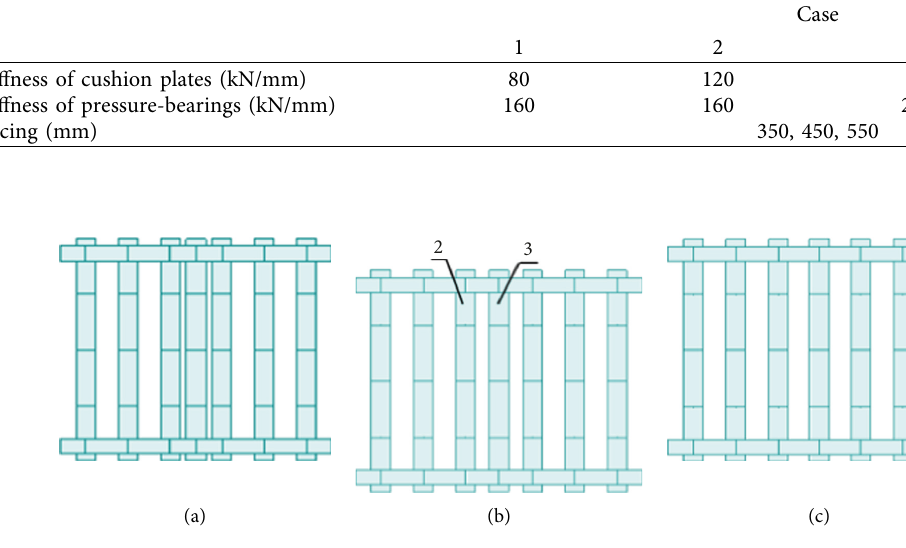
Figure 5: The top view of the BEJs model: (a) sleeper spacing is 350mm,(b) 450mm, and (c)